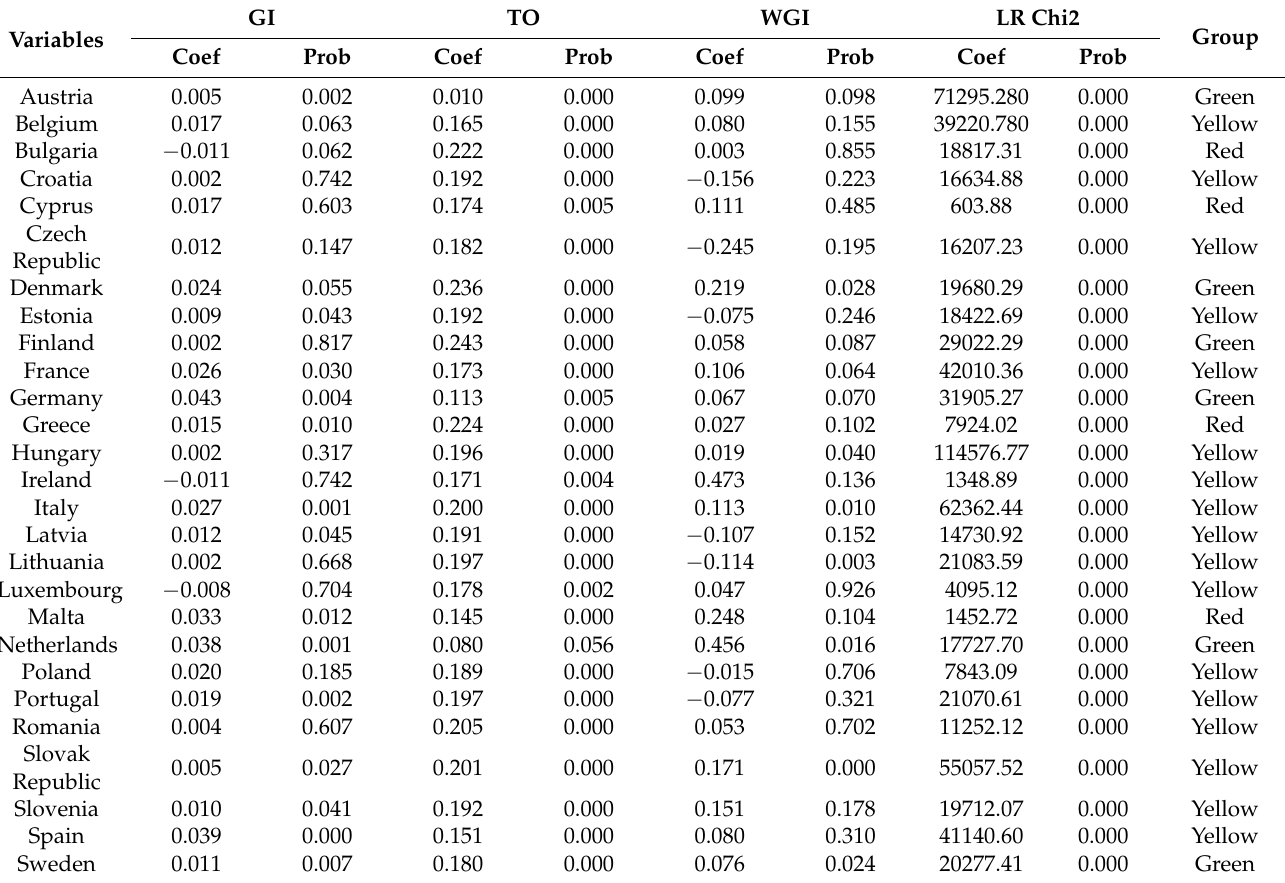
Table 6. The findings of the Tobit model for each